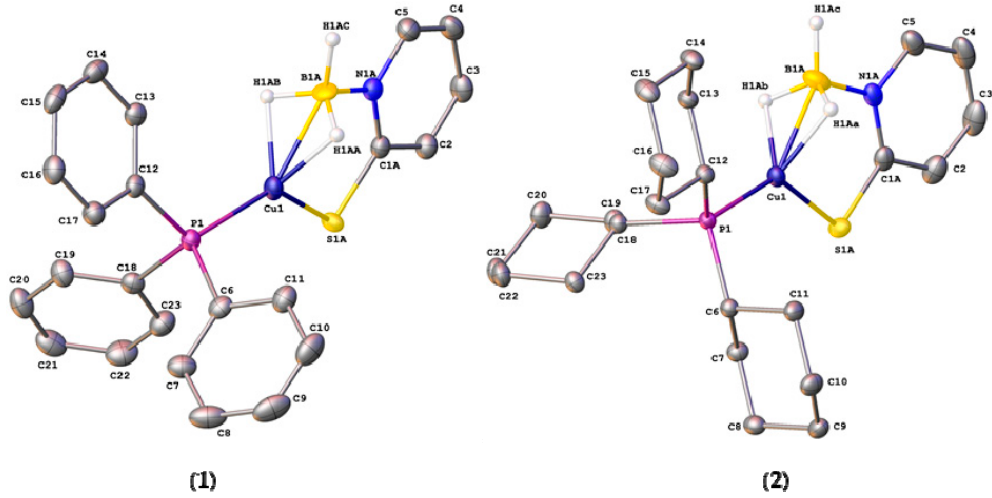
Figure 3. Molecular structures of [Cu{ κ 3 - S,H,H -H 3 B(mp)}(PR 3 )] (R = Ph, 1 ; Cy, 2 ). Thermal ellipsoids drawn at 50% level. Hydrogen atoms, with the exception of those attached to the boron centers, have been omitted for clarity. Both structures contain disorder in the position of the [H 3 B(mp)] − ligand. Only the major component is shown (see text for details). Table 2. Selected Bond Distances (Å) and Angles ( ◦ ) for 1 – 3